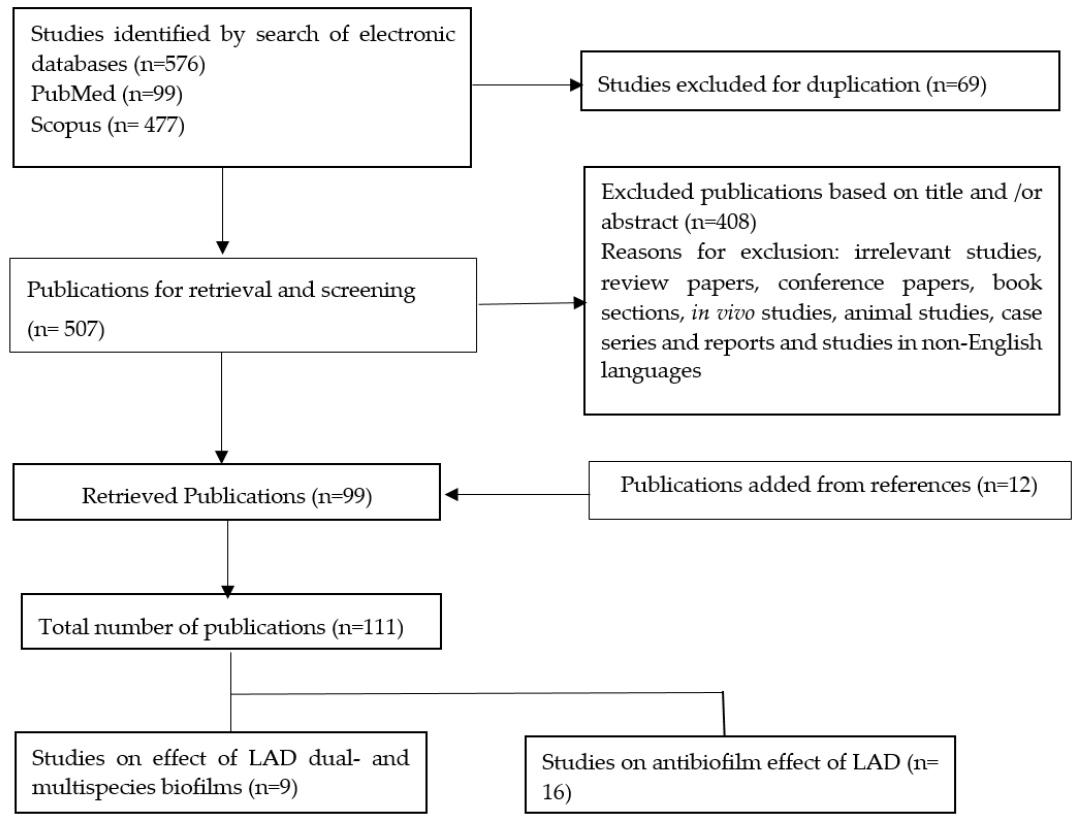
Figure 1. Flow diagram of the review search process and results.